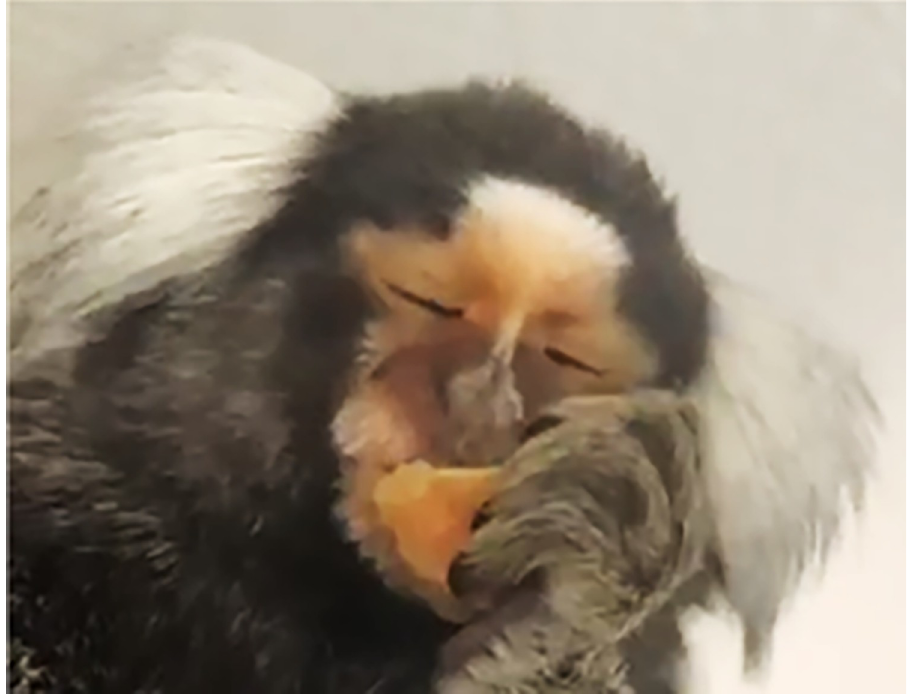
Fig 9. AU43—eye closure/AU45—blink at the apex with appearance change 3. C. Minimum criteria: the eyelids move towards each other (or only upper eyelid) and cover the eyeball completely.